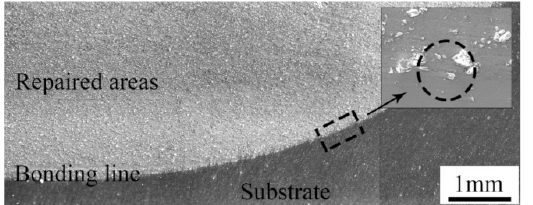
Figure 4. Cross-section of samples repaired with the cold spray